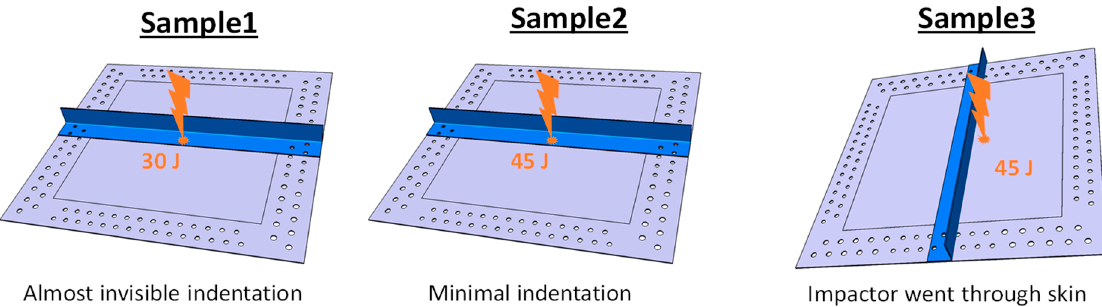
Figure 16. Impact locations and energy for the three samples: Sample1 and Sample2 were impacted at the same point of the stiffener flange, Sample3 was impacted on the skin.